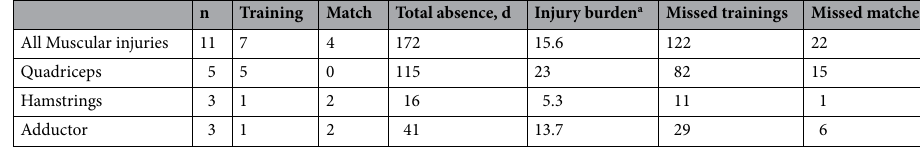
Table 3. Incidence of muscular injuries according to the body’s zone. a Injury burden is expressed as the number of days of absence/number of